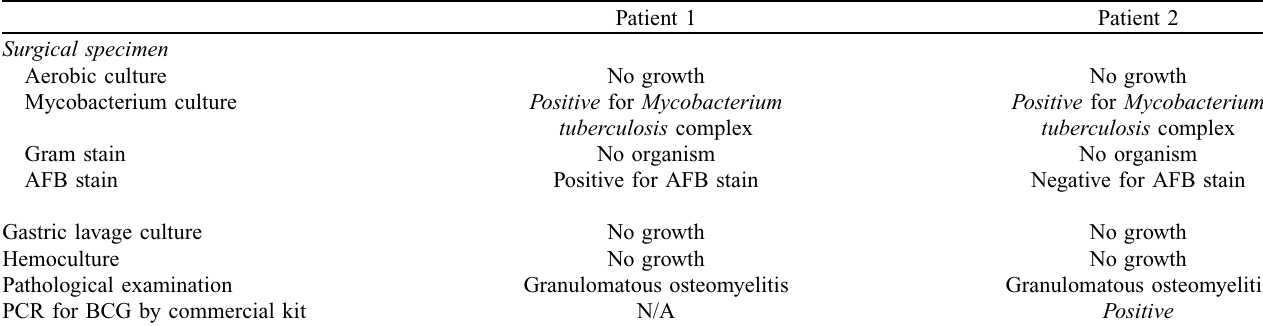
Table 2. Results of bacteriological investigations of both patients.